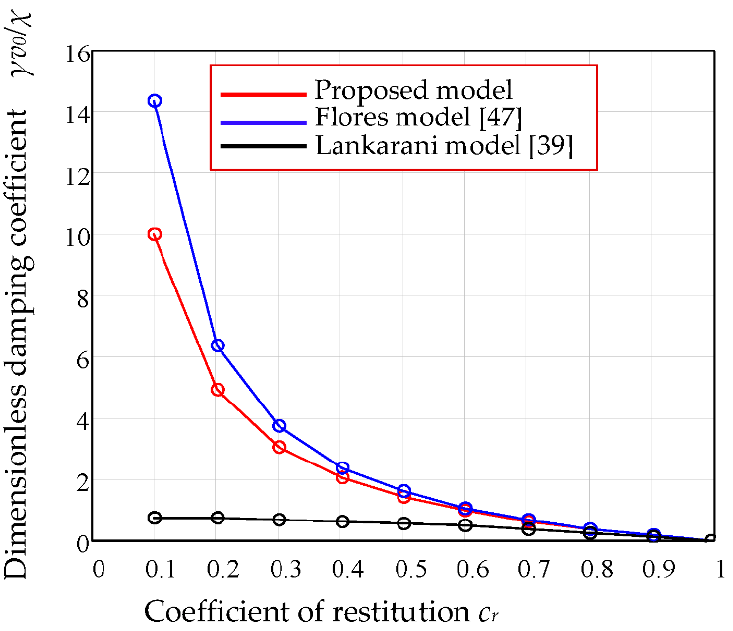
Figure 22. The variation of γ coefficient versus coefficient of restitution ( c r ).